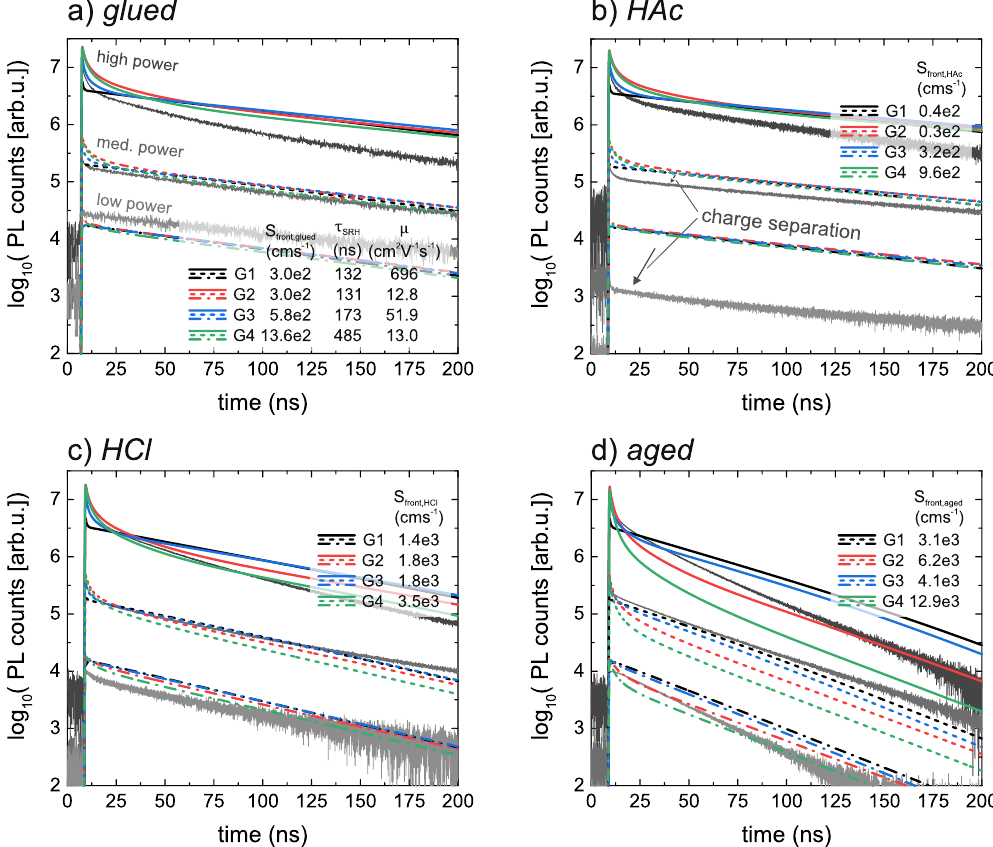
Figure 8. Simulated (colored) and measured (black) transients of the bg-CIGS absorber for the parameter sets G1-G4 as presented in Fig. 6. G1 and G3 are the two sets with rather high mobilities, while G2 and G4 have low μ but span a large range of τ SRH